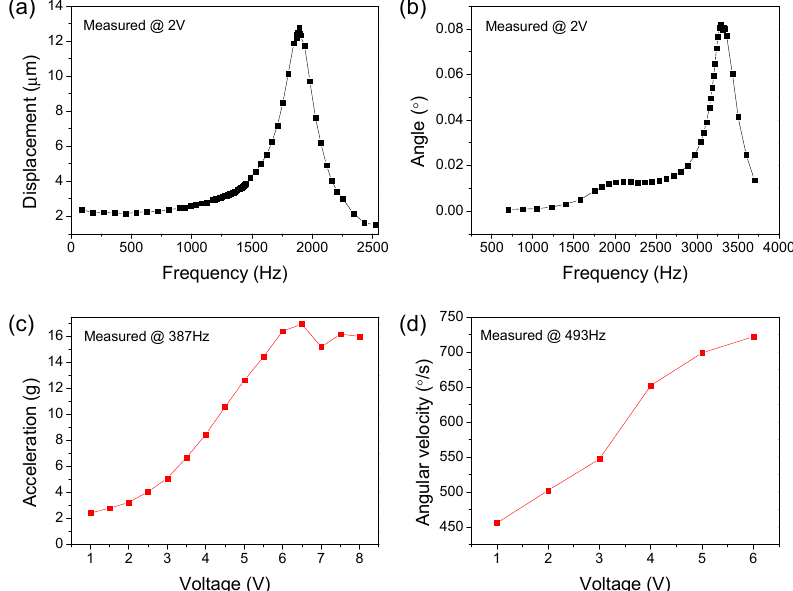
Figure 6. Measured dynamic response of the micro-vibrator via laser doppler vibrometer. ( a ) The amplitude-frequency characteristics and ( b ) angle-frequency characteristics of the unloaded